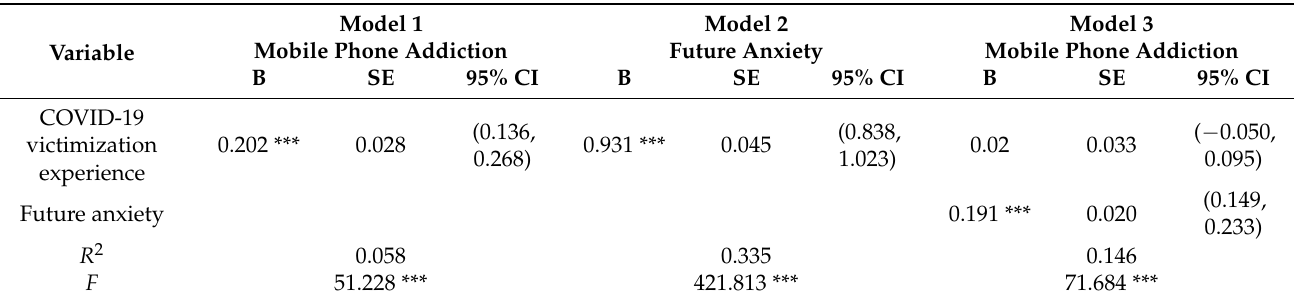
Table 7. Testing the mediation model of future